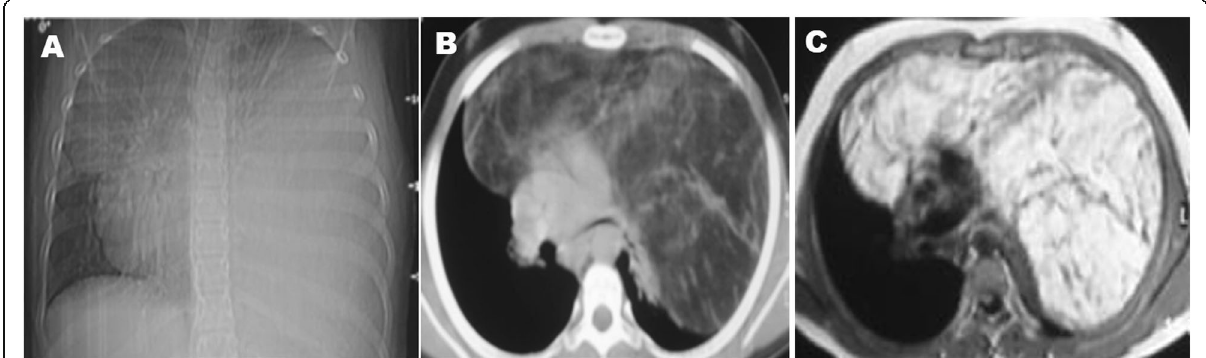
Fig. 1 a Chest X-ray PA view shows a near-total opacification of the left hemithorax and right upper lung zone merging with the mediastinum. b Axial CT chest mediastinal window shows a large fat attenuating mass with thin hypodense fibrous septae. c MRI lung T1 WI shows the hyper- intense signal of the mass confirming its fatty nature. Imaging diagnosis and histopathologic assessment revealed “ thymolipoma